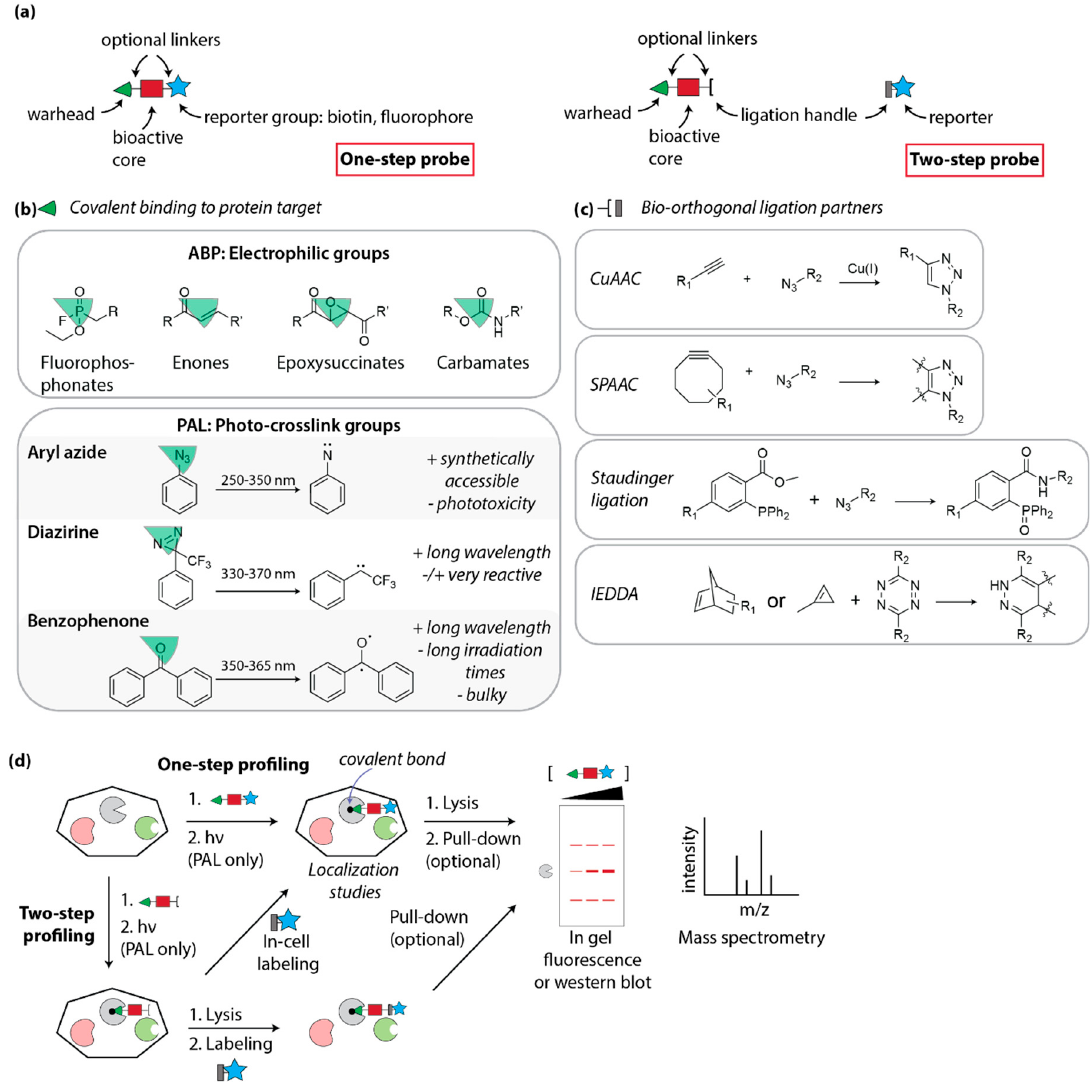
Figure 1. Label-based approaches. ( a ) General structures of one- and two-step probes. ( b ) Examples of warheads for activity-based probes (ABP) and photo-affinity labeling (PAL). ( c ) Examples of bio-orthogonal ligation reactions for use in two-step profiling. ( d ) Schematic representation of a cell-based profiling experiment, either through direct (one-step) or indirect (two-step) labeling.